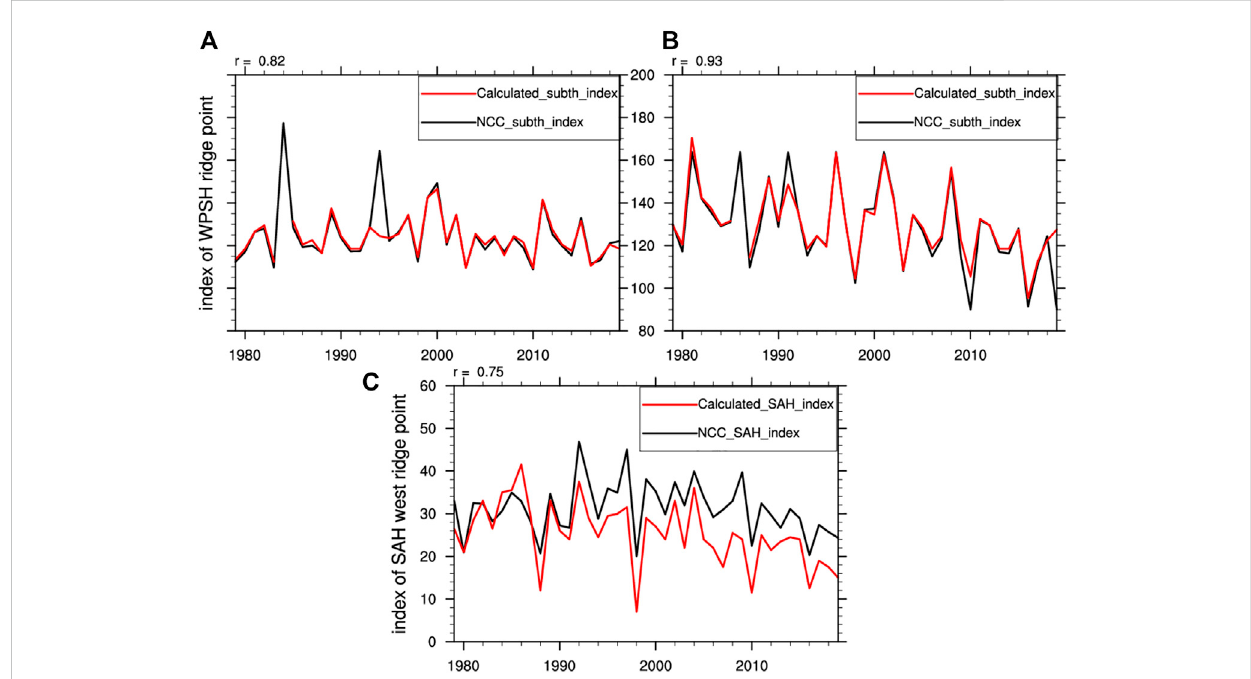
FIGURE 1 Westernridgeindexofthe588dagpmisolineofthewestPaci fi csubtropicalhighcalculated(solidredline)andthatprovidedbytheNCC(solidblack line) in (A) July and (B) August, and (C) calculated western ridge point index of the SAH from 1979 to 2019. Solid red and black lines represent the calculated index of the SAH and that provided by the NCC,